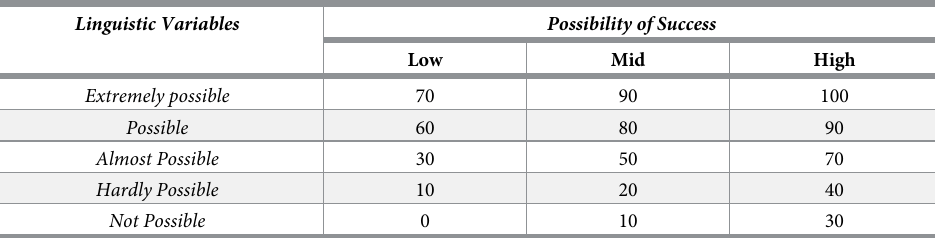
Table 3. Verbal fuzzy